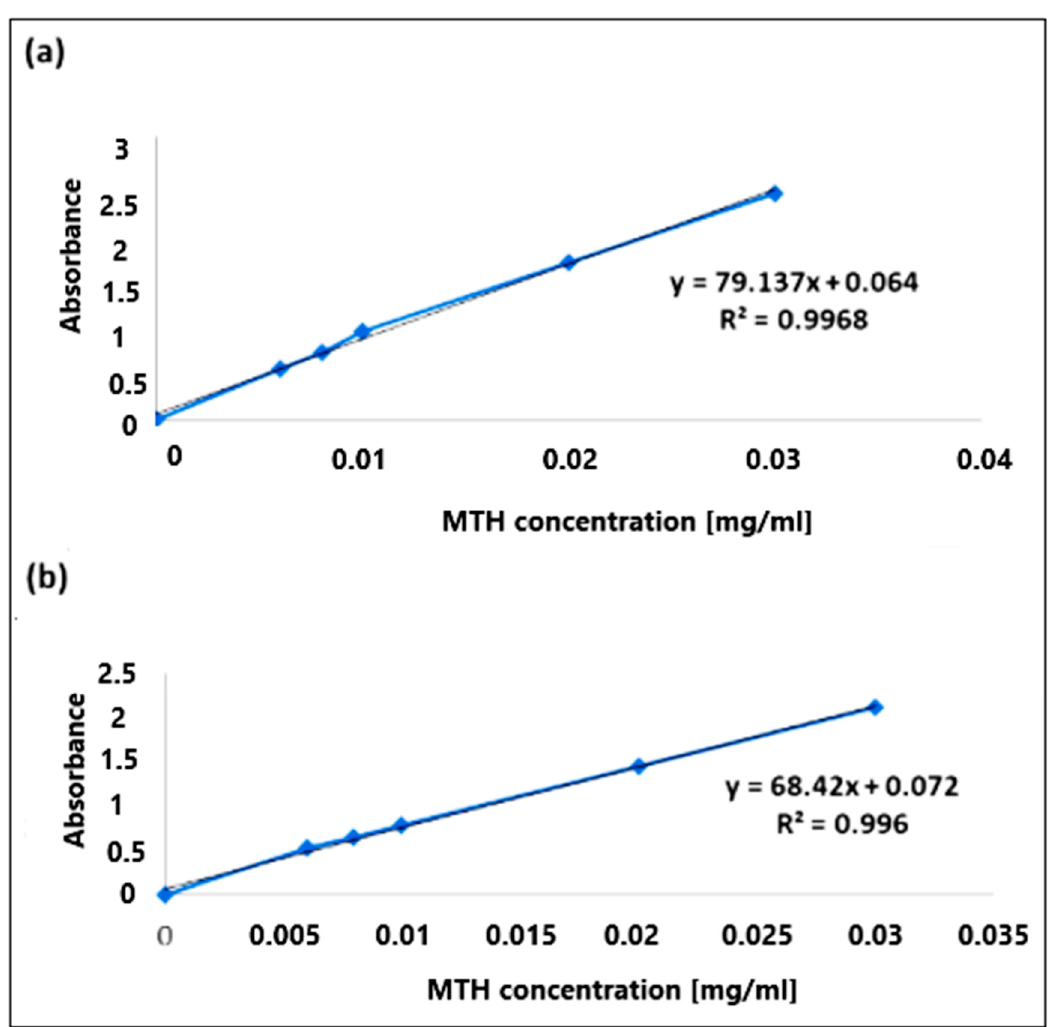
Figure 8. Calibration curves of metformin hydrochloride at pH 1.2 ( a ) and pH 6.8 ( b ).